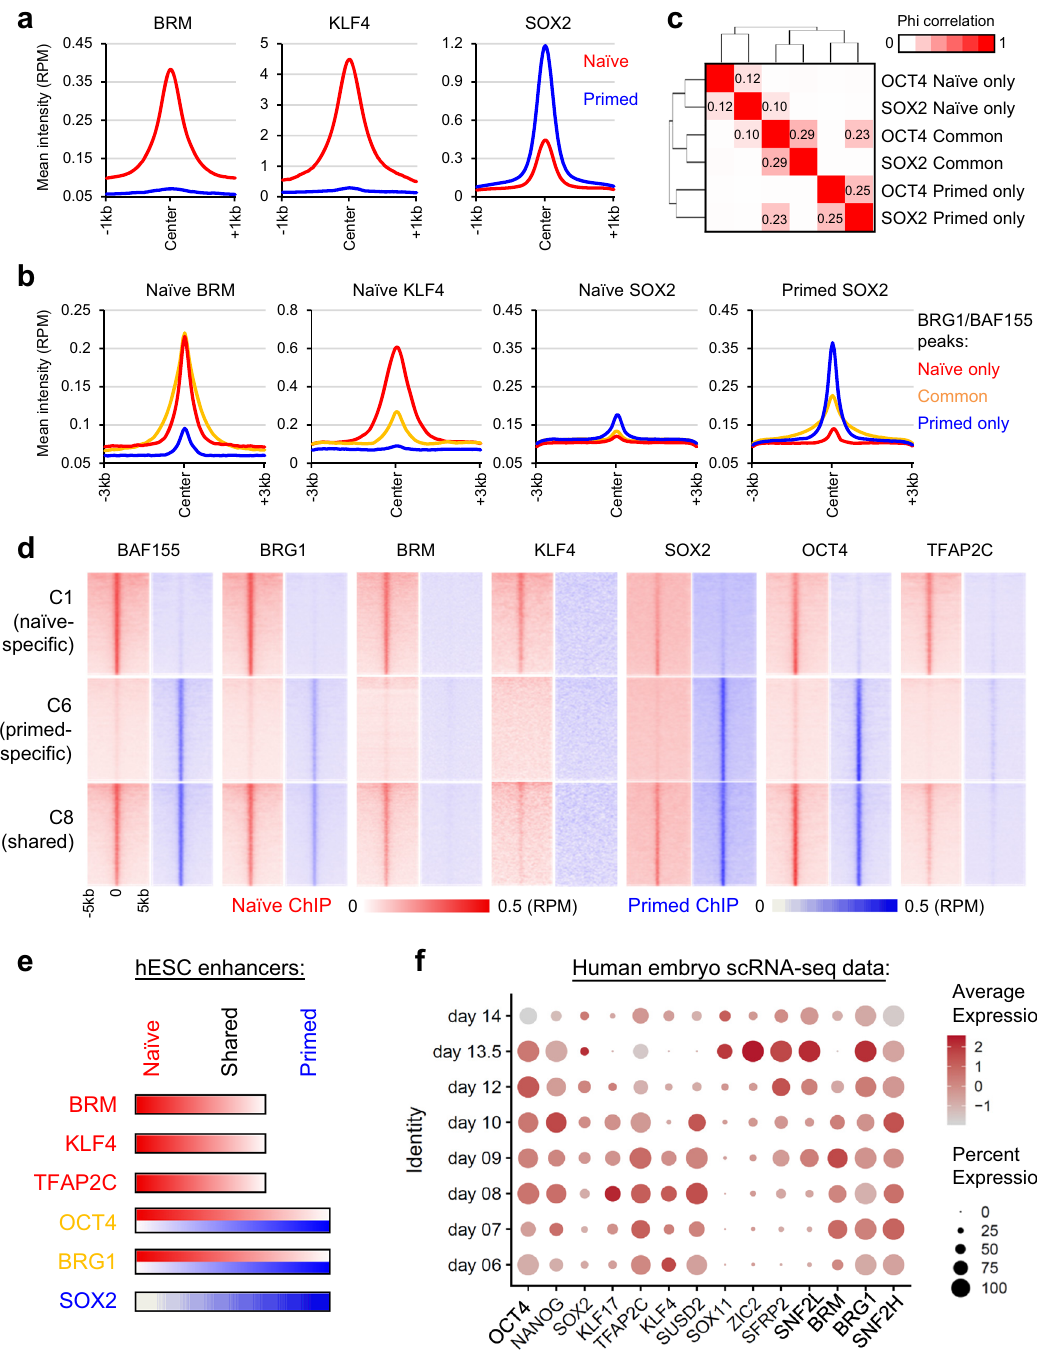
Fig. 4 Naïve and primed-speci fi c enhancers harbor distinct chromatin remodelers and TFs. a Mean intensity plots of BRM, SOX2 (ChIP-seq), and KLF4 (CUT&Tag) signals in naïve and primed hESCs. b Mean intensity plots of BRM, KLF4, and SOX2 signals at naïve-only, primed-only, and naïve/primed- common BAF peaks. c Correlation analysis of OCT4 and SOX2 chromatin association in naïve and primed hESCs grouped by naïve-only, primed-only, and naïve/primed-common OCT4 or SOX2 peaks. d Intensity heatmaps of BAF subunits, KLF4, SOX2, OCT4, and TFAP2C signals at clusters C1, C6, and C8 regions in naïve (left) and primed (right) hESCs. e Summary of activities of chromatin remodeling complexes and TFs in naïve (C1), primed (C6), and shared (C8) enhancers in hESCs. f Expression of OCT4-associated chromatin remodelers and TFs in single-cell RNA-seq analysis of human embryos cultured in vitro between days 6 and 14 of human development 57 . Average gene expression levels and the percentage of cells that express each gene are presented with differential color intensities and circle sizes, respectively. Note that KLF17 and SUSD2 are markers associated with naïve pluripotency, while SFRP2 and SOX11 are associated with primed